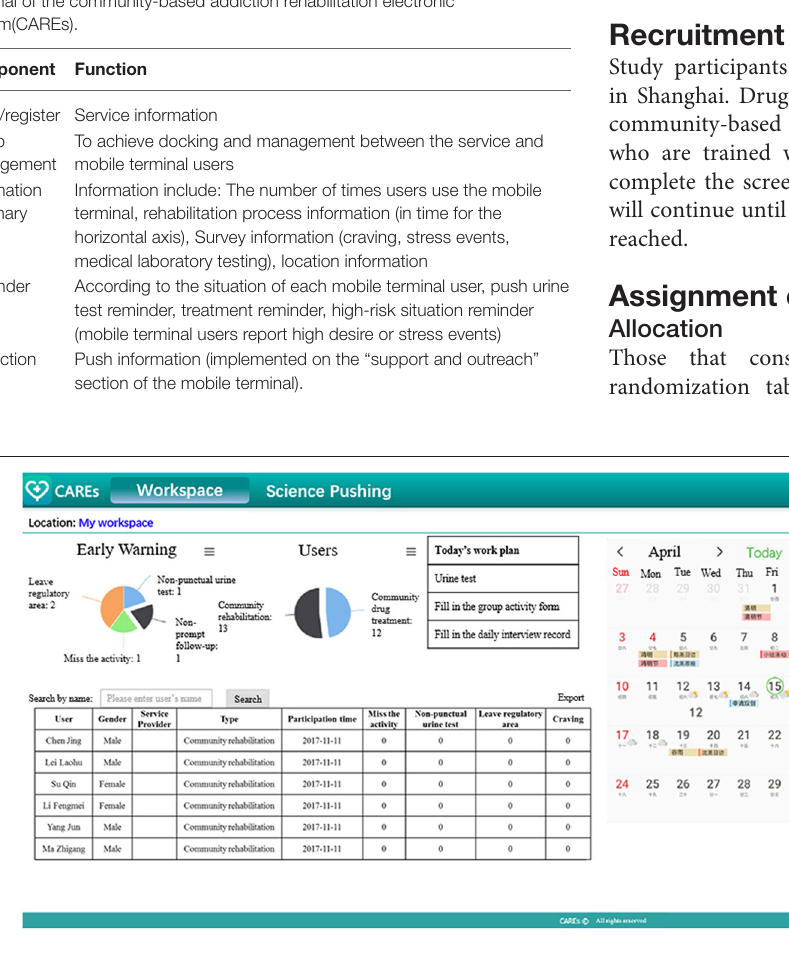
Frontiers in Psychiatry |